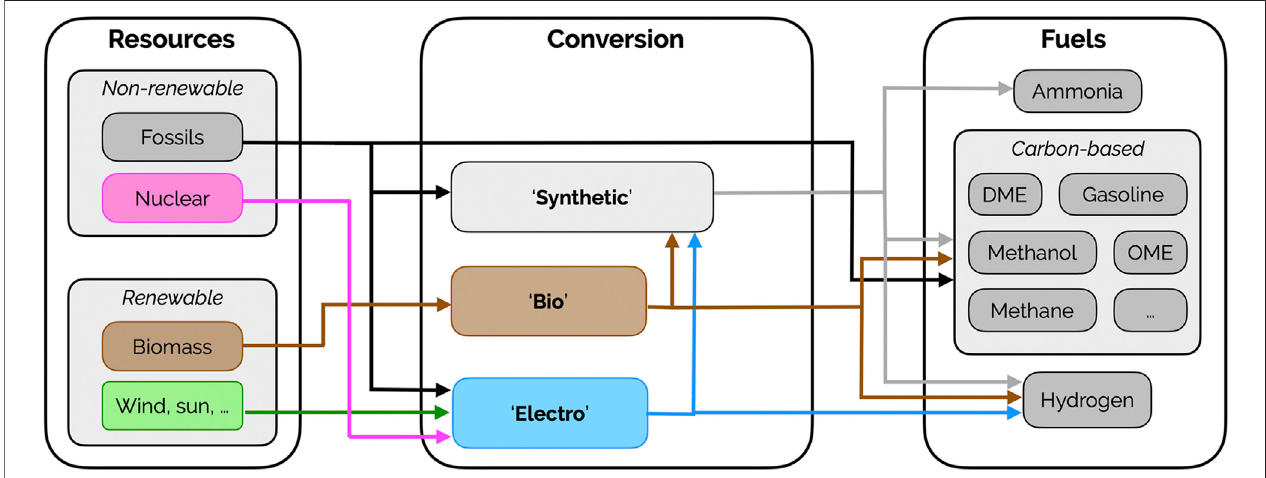
FIGURE1| Overview ofthemain pathways toproduce fuels.The boxesin the “ conversion ” categoryillustrates theterminology tousein thedifferentcases: fi rst, a fuel can be de fi ned as bio or electro if the absolute majority of the energy balance of its production consists of biomass or electricity, respectively. Then, a fuel can be de fi nedas synthetic ifithasbeenobtainedthroughasynthesisprocessfromanotherfuel,regardless ofthefeedstock.Thebox “ Fuels ” givessomeexamples toillustrate the terminology used and applied to very common fuels.